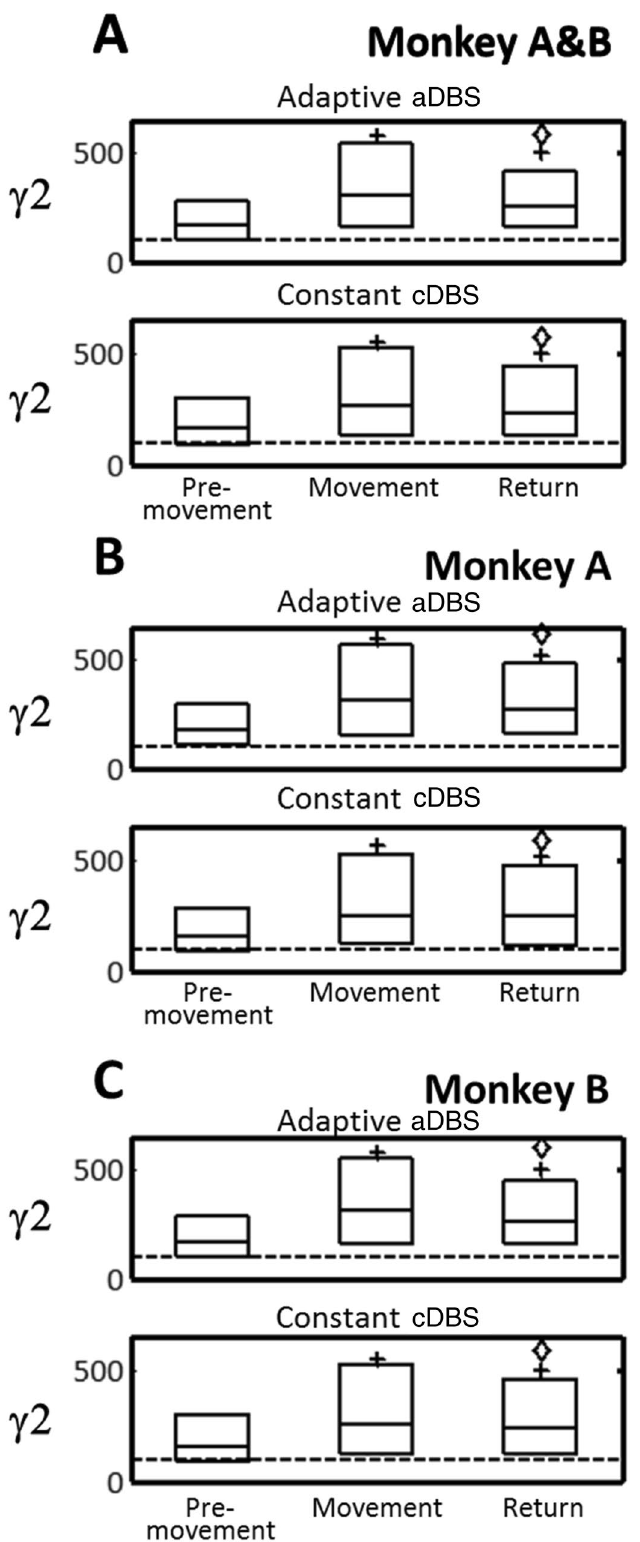
Figure 7. Power spectrum density in γ2 band during motor task periods (Premovement, Movement, and Return) with aDBS (upper) and cDBS (lower). ( A ) Monkeys A and B combined. ( B ) Monkey A. ( C ) Monkey B. Data are expressed as percents of the median during Rest. Box plots indicate median and interquartile range (25th-75th percentiles). + P < 0.05, significantly different from Premovement; ◊ P < 0.05, significantly different from